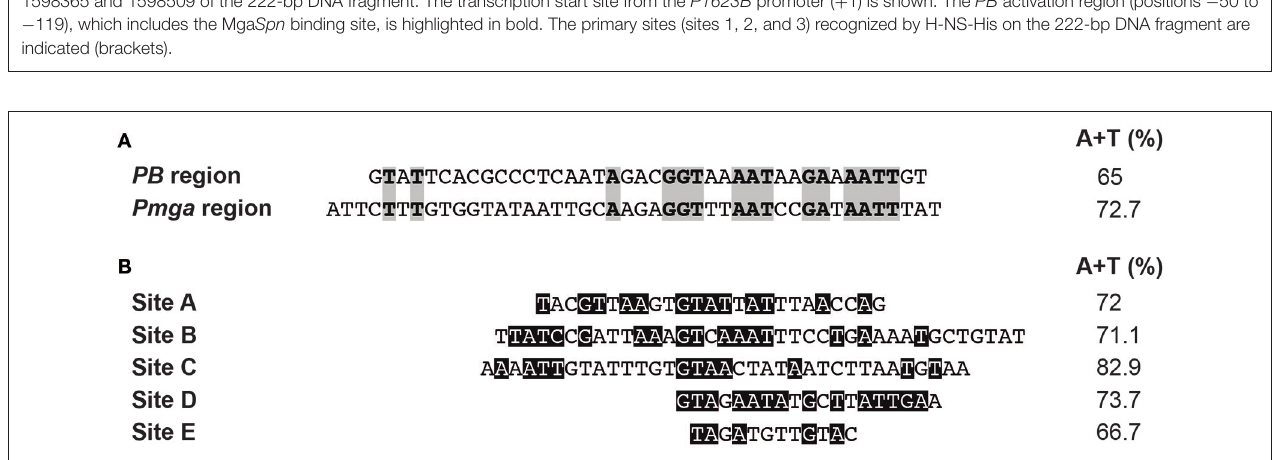
FIGURE 8 | Sites recognized by Mga Spn . (A) Nucleotide sequence alignment of the PB activation region and the Pmga promoter region of the pneumococcal R6 genome. Both Mga Spn binding sites were defined by hydroxyl radical footprinting assays ( Solano-Collado et al., 2013). Identical nucleotides are highlighted in gray boxes. (B) Nucleotide sequence alignment of the regions recognized by Mga Spn -His on the hly regulatory region of the E. coli plasmid pHly152 (this work). These Mga Spn -His binding sites were defined by DNase I footprinting assays. Nucleotides of such sites that are present in the PB activation region and/or the Pmga promoter region are highlighted in black boxes. The A + T content of the different sites is indicated on the right. The global A + T content of the pneumococcal R6 genome is 60.3%. By EMSA, the minimum DNA size required for Mga Spn binding was shown to be between 20 and 26 bp (Solano-Collado et al.,